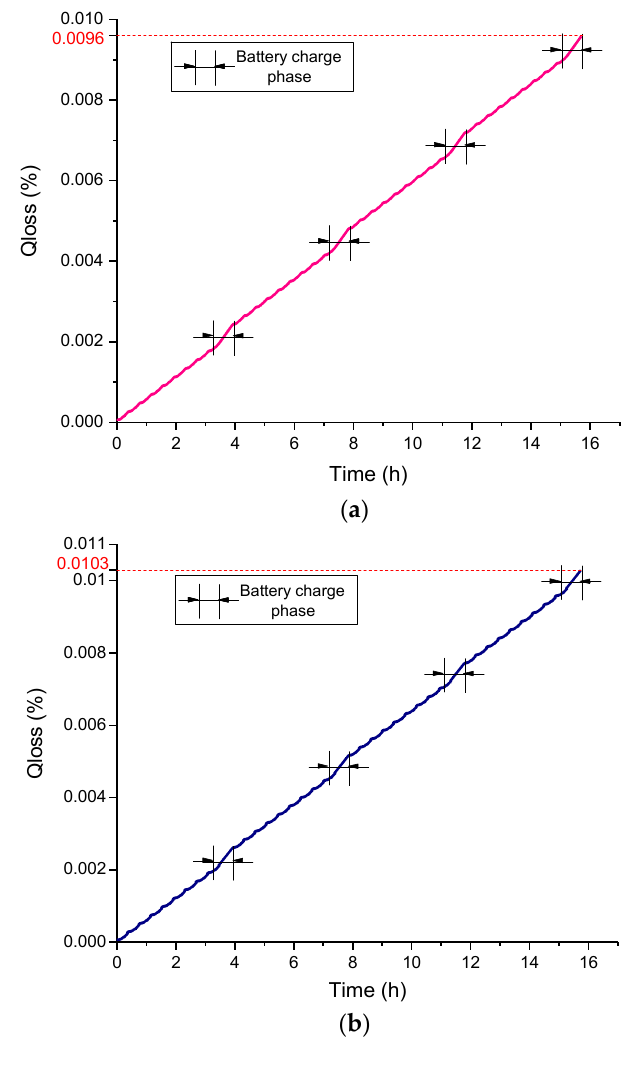
Figure 18. Q loss based on the two strategies in one day: ( a ) battery degradation percentage based on convex optimization strategy; and ( b ) battery degradation percentage based on rules strategy.